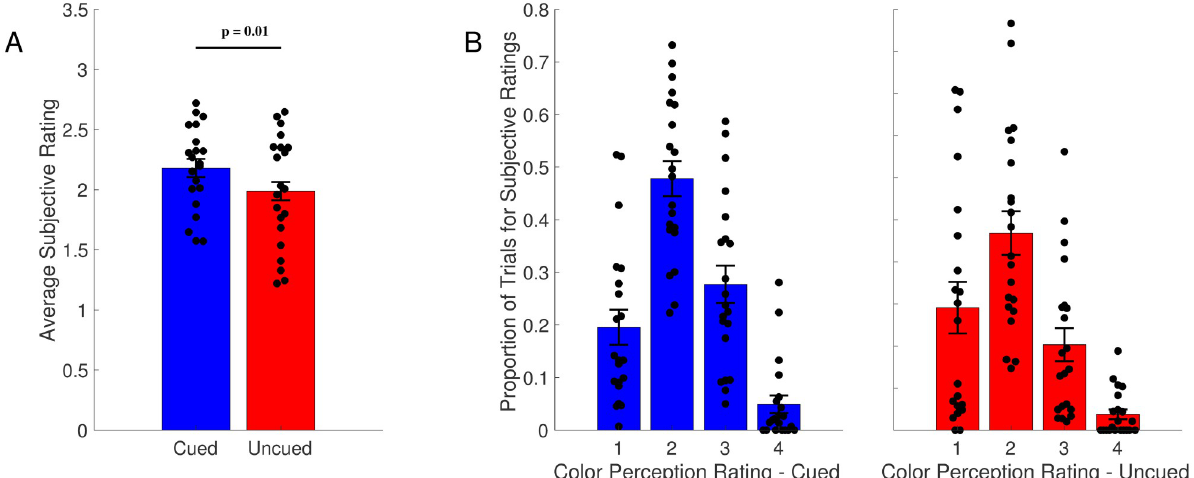
Fig 3. Subjective ratings for color diversity judgments in Experiment 1. (A) Average subjective rating for color diversity judgments for the cued and uncued rows. Subjective ratings for uncued rows were significantly lower than cued rows. (B) Proportion of trials for each subjective rating type. The main difference between ratings for the cued and uncued trials were differences in the frequencies of the “1” and “3” responses. Error bars show SEM across